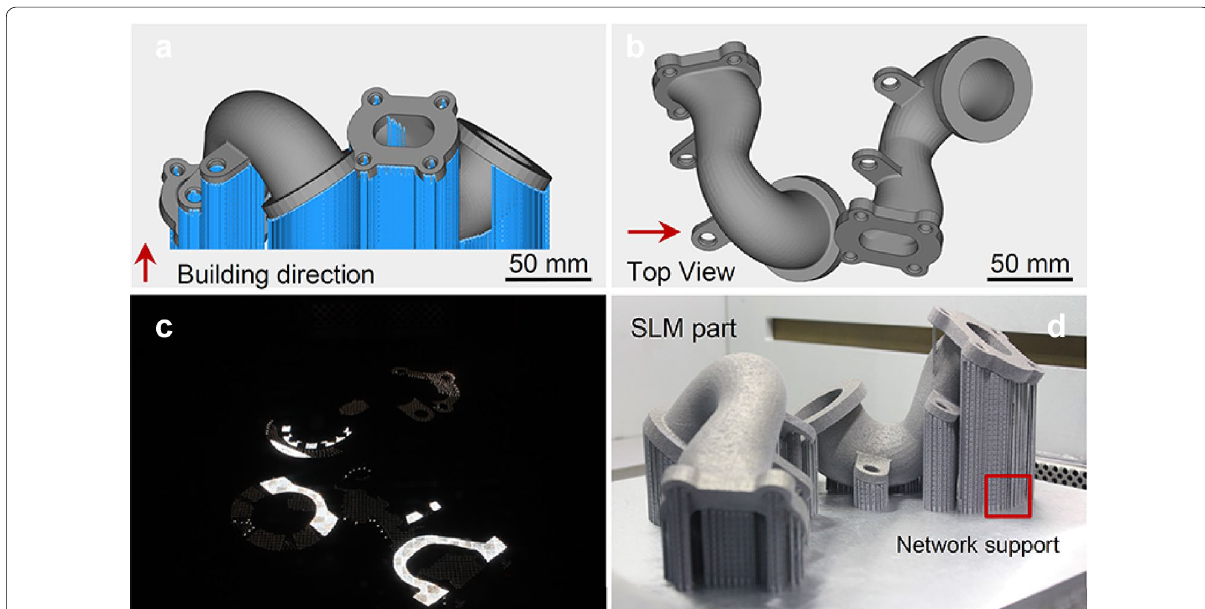
Figure 12 a The model in Materialise Magics; b top view of the model; c the photo of SLM processing; d complex shaped Al-based components fabricated by